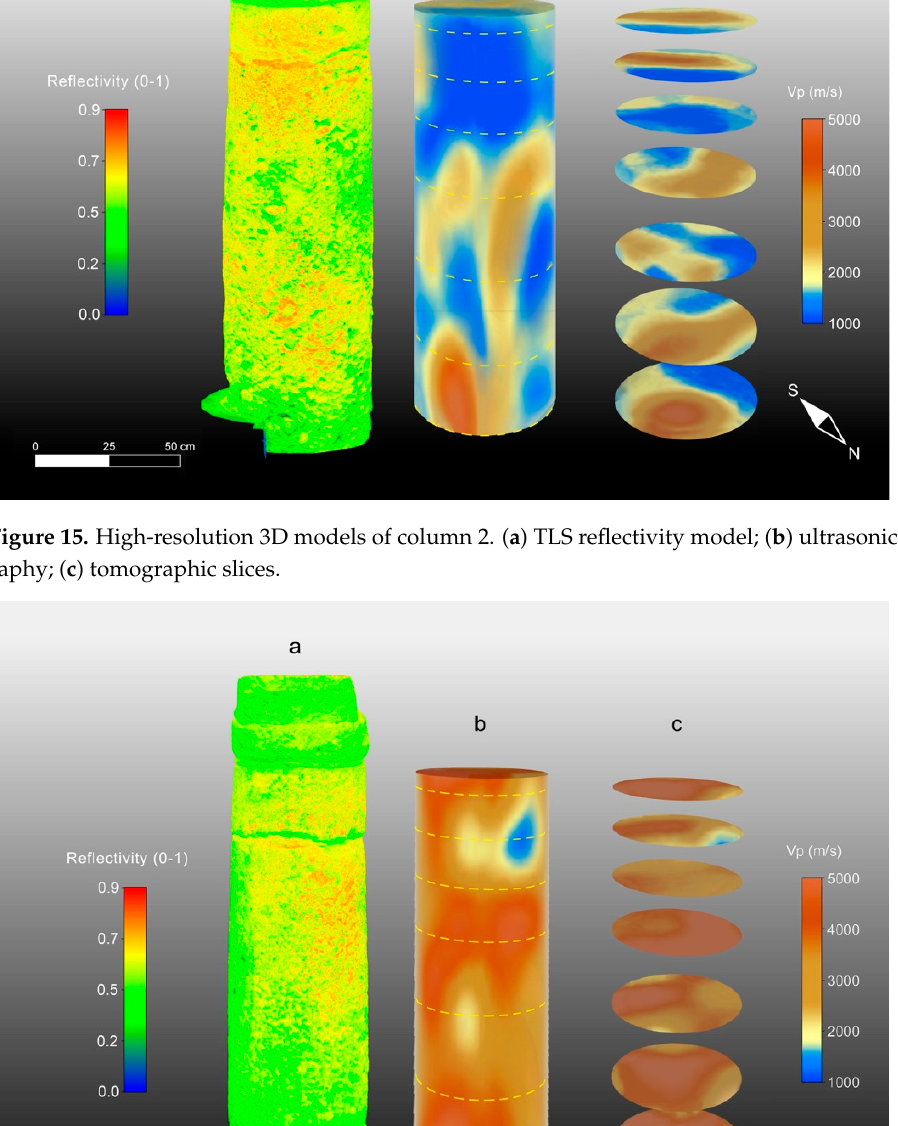
Figure 16. High-resolution 3D models of column 3. ( a ) TLS reflectivity model; ( b ) ultrasonic tomog- raphy; ( c ) tomographic slices.